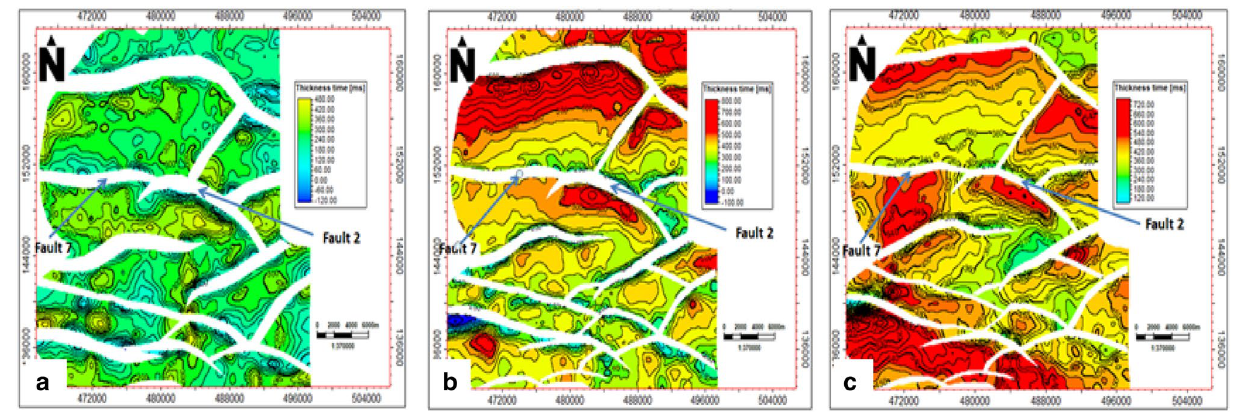
Fig. 15 Thickness map (isopach) of a MFS 33.0–34.0 showing pre-growth stage, b MFS 31.3–33.0 showing major growth stage of fault 2 adja- cent sediments, c MFS 28.1–31.3 showing major growth stage of fault 7 adjacent sediments and minor growth stage of fault 2 adjacent sediments